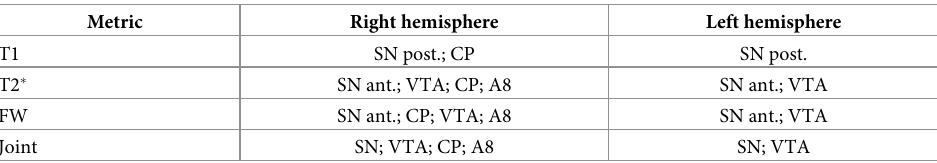
Table 4. Regions of the brain overlapping with H 1